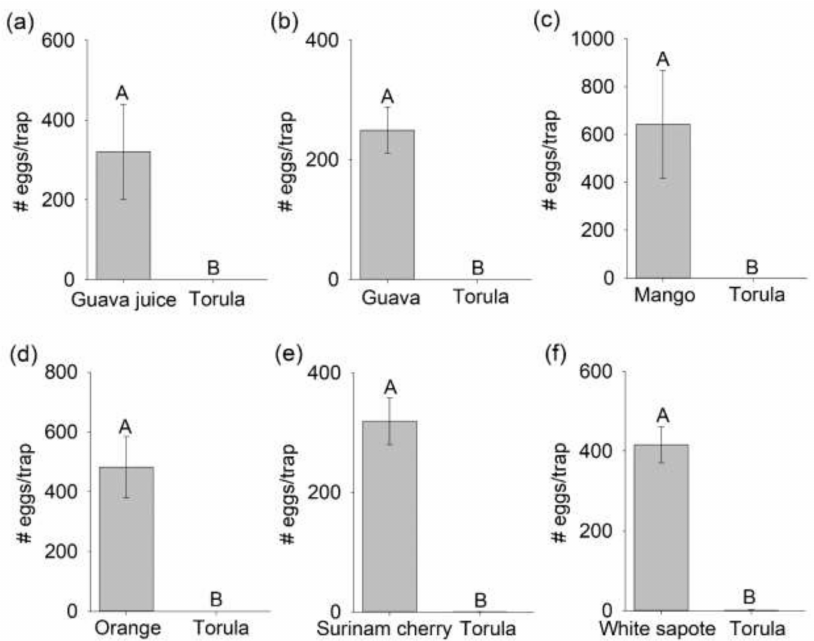
Figure 2. Number of Bactrocera dorsalis eggs (mean ± SEM) oviposited in gated cup traps baited with either torula yeast and one of the six host fruit sources (( a ) guava juice, ( b ) guava, ( c ) mango, ( d ) orange, ( e ) Surinam cherry, and ( f ) white sapote) in two-choice laboratory assays. Different letters on bars indicate significant differences by Tukey–Kramer tests at p <